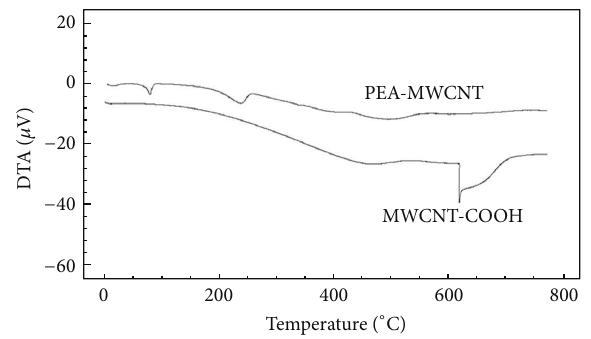
Figure 2: DTA of MWCNT-COOH, PEA-MWCNT.